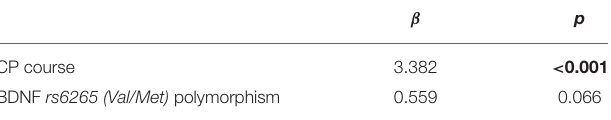
TABLE 3 | Predictors of EDSS score based on a linear regression